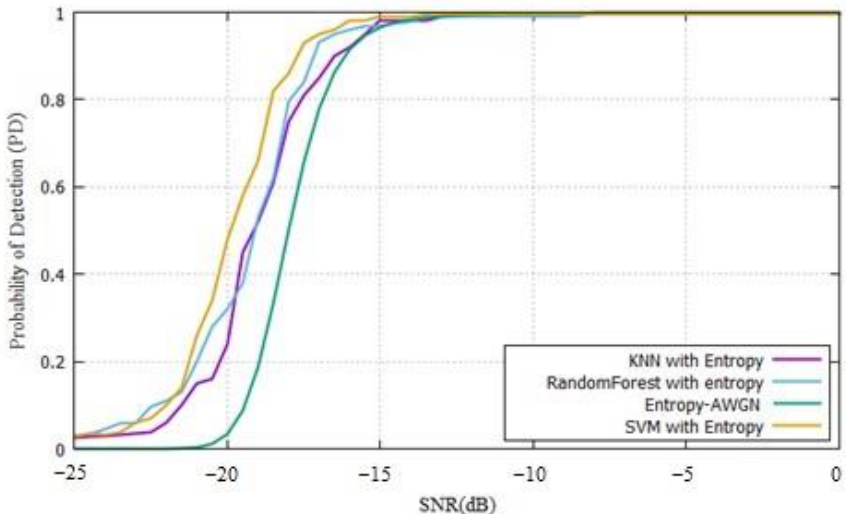
Figure 18. Probability of detection with ML techniques compared to entropy from [23].